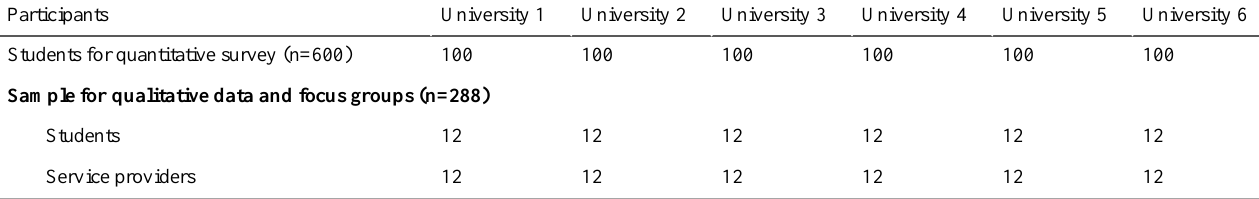
Table 1. Design of the contextual assessment for each participating university site in Shandong, Jinan,